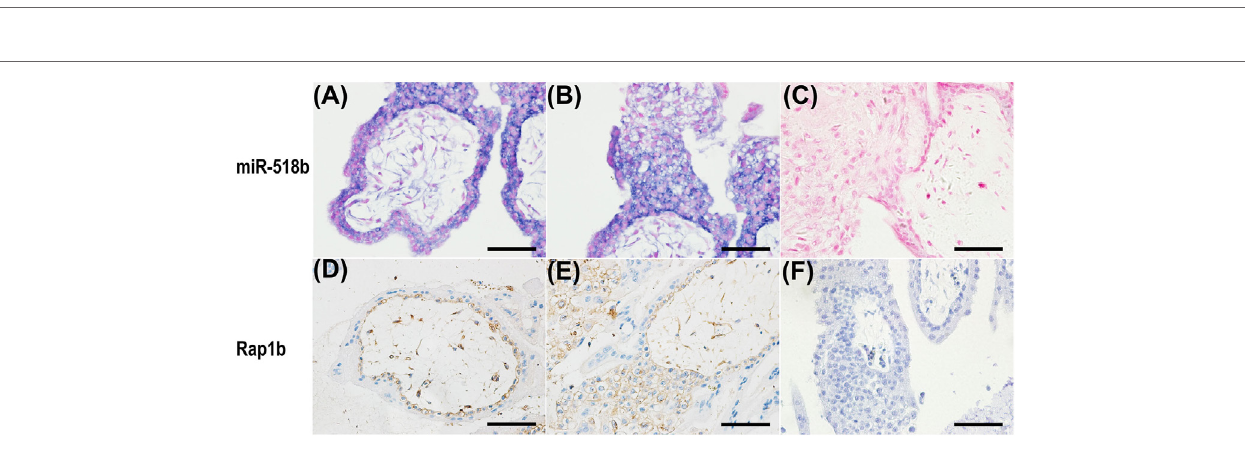
FigUre 1 | Expression pattern of Rap1b in preeclamptic placentas. (a,b) Real-time PCR to measure the mRNA expression of Rap1b in basal plate (a) and chorionic plate (b) of placentas from severe preeclamptic patients (sPE, n = 8) and gestational week-matched preterm labor (PTL, n = 8). (c–F) Western blotting to measure the protein level of Rap1b in basal plate (c) and chorionic plate (D) of the placentas from PTL and sPE patients, each of the lanes stood for one patient. (e) and (F) represent the statistical results of (c,D) , respectively. The correlation between the expression of miR-518b and Rap1b in placentas is shown as (g) . Data are presented as mean ± SEM. * P <